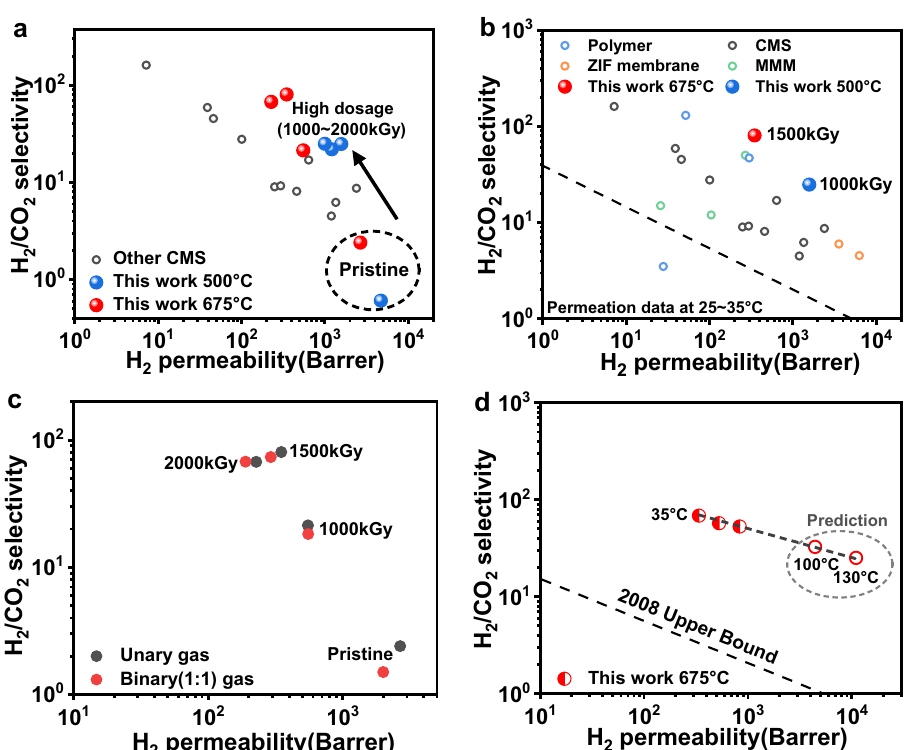
Fig. 4 | Gas separation performances of the highly irradiated CMS membranes in H 2 /CO 2 pair. a H 2 /CO 2 permeation data of pristine and highly electron- irradiated CMS membranes for two different temperatures (500°C and 675°C) including other state-of-the-art CMS membranes. b H 2 /CO 2 permeation data of 500°C 1000kGy- and 675°C 1500kGy-CMS including other state-of-the-art